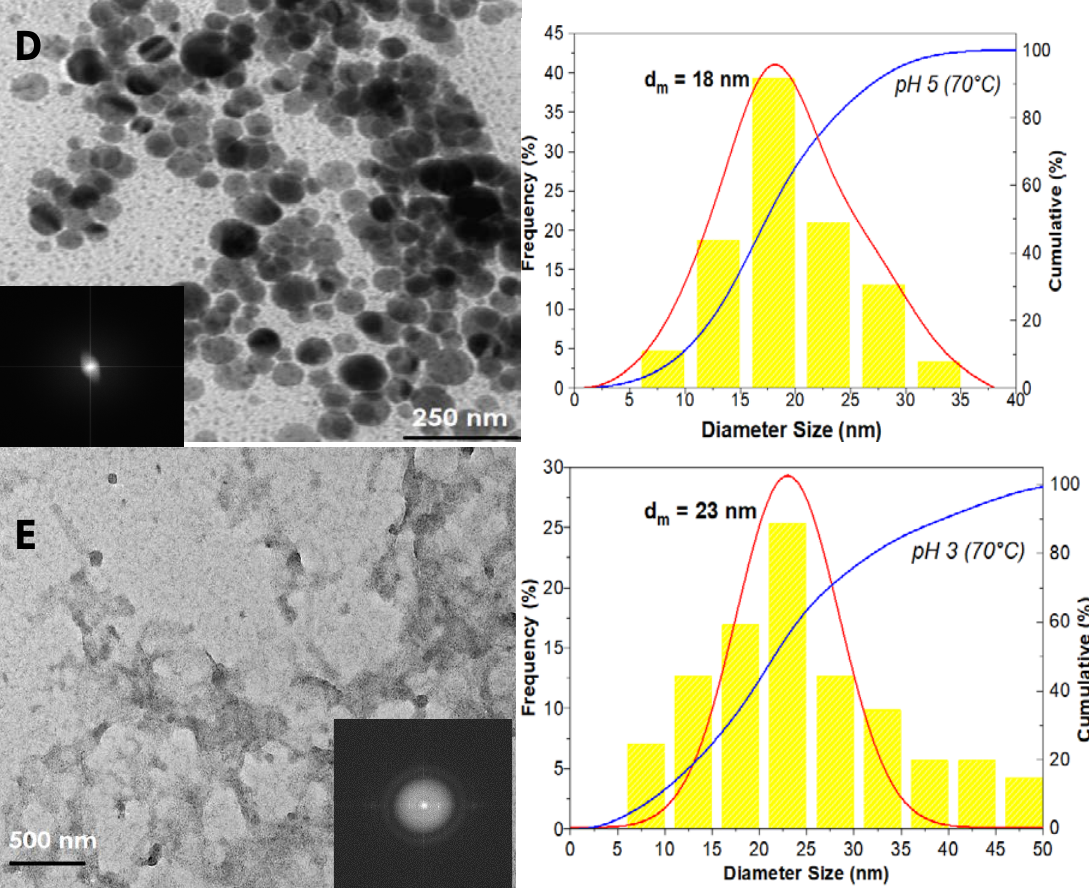
Figure 1. TEM images of pure ZnO and ZnO-TA nanostructures showing particle size distribution plots based on the Gaussian distribution factor (red line) with cumulative analysis (blue line). Pure ZnO nanostructures are synthesized at ( A ) 50, ( B ) 70, and ( C ) 90 °C. Meanwhile, the representative sample of ZnO-TA nanostructures is made using pure ZnO nanostructures synthesized at 70 °C which yield pH value of ( D ) 5 and ( E ) 3. The inset shows the SAED pattern for the respective ZnO samples.